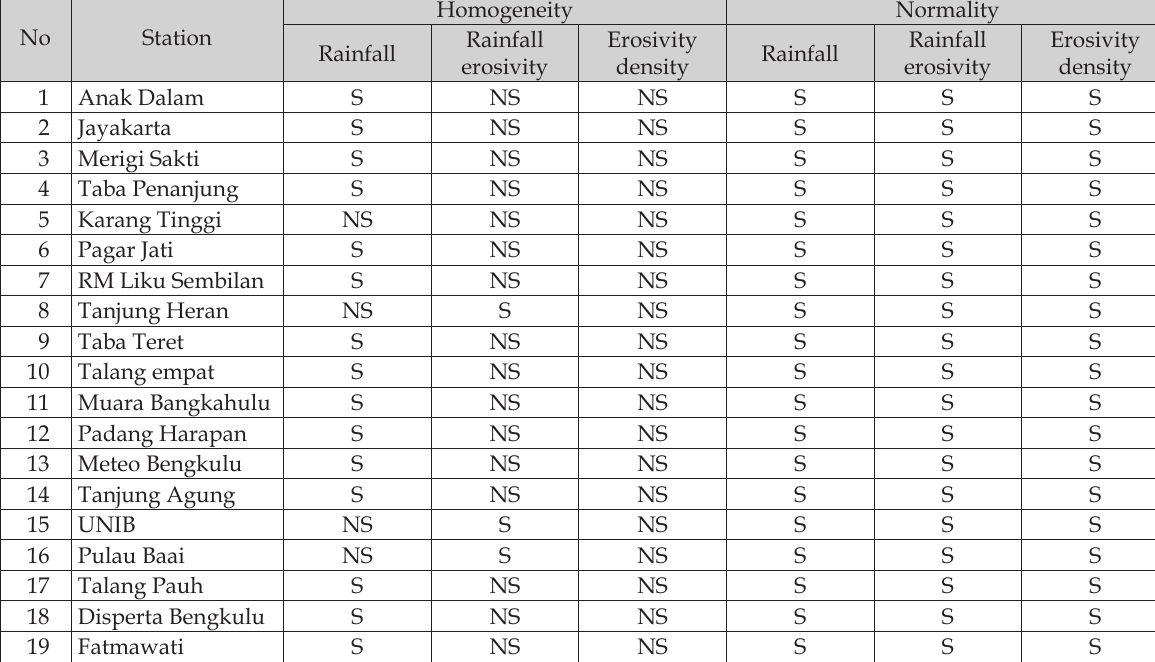
Table 2. Homogeneity test (Bartlett’s test) and statistic Shapiro-Wilk’s (SW) parametric test on the weather